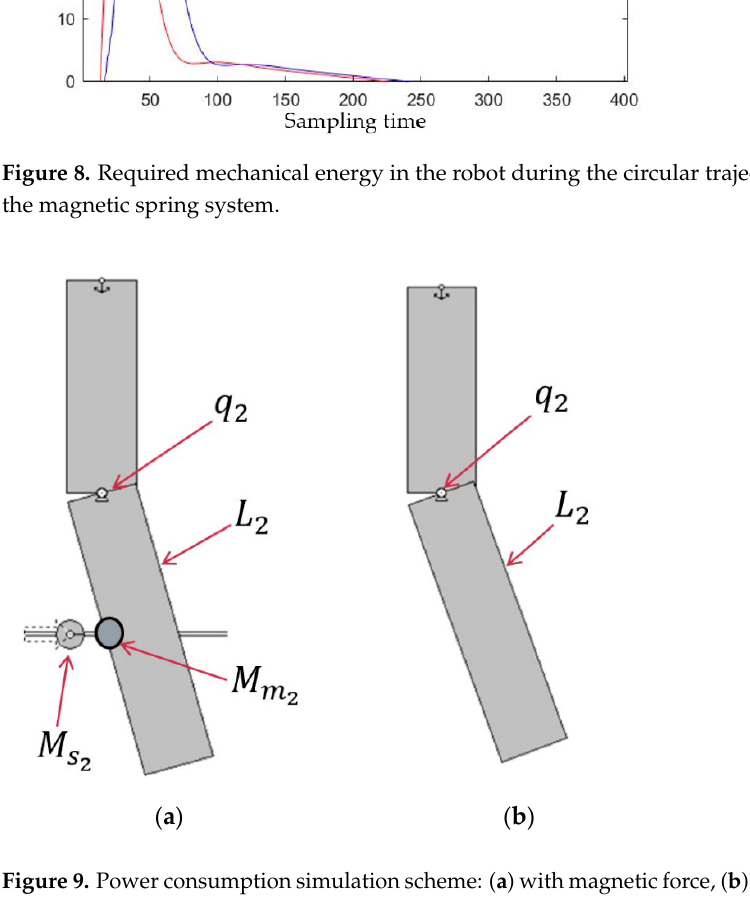
Figure 9. Power consumption simulation scheme: ( a ) with magnetic force, ( b ) without magnetic force .